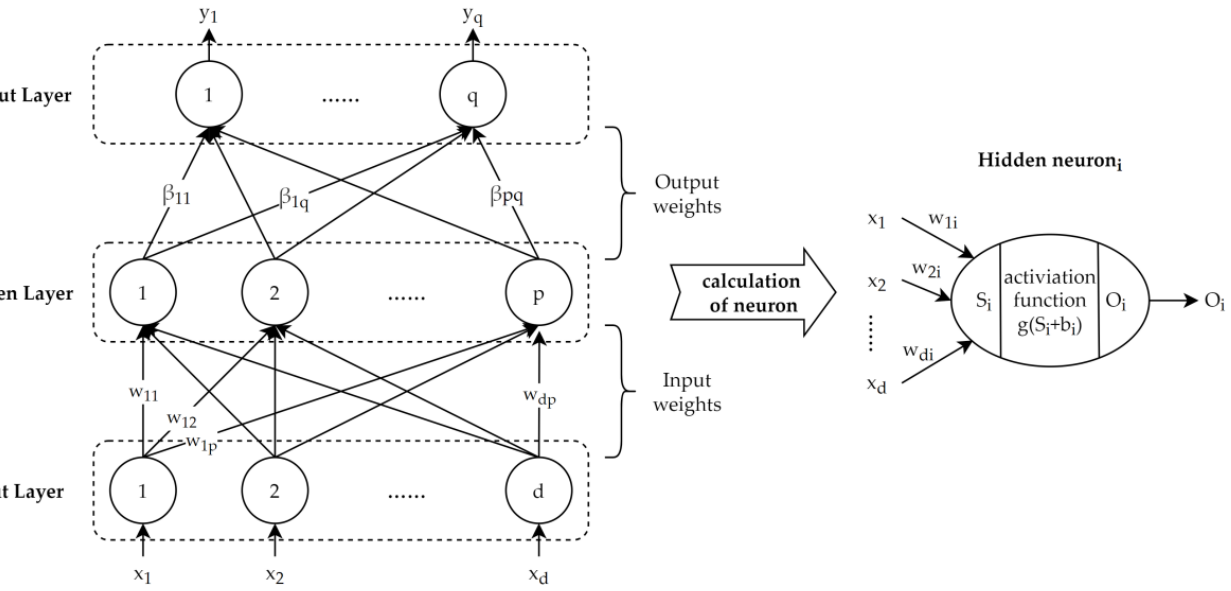
Figure 1. The flowchart of PCA.